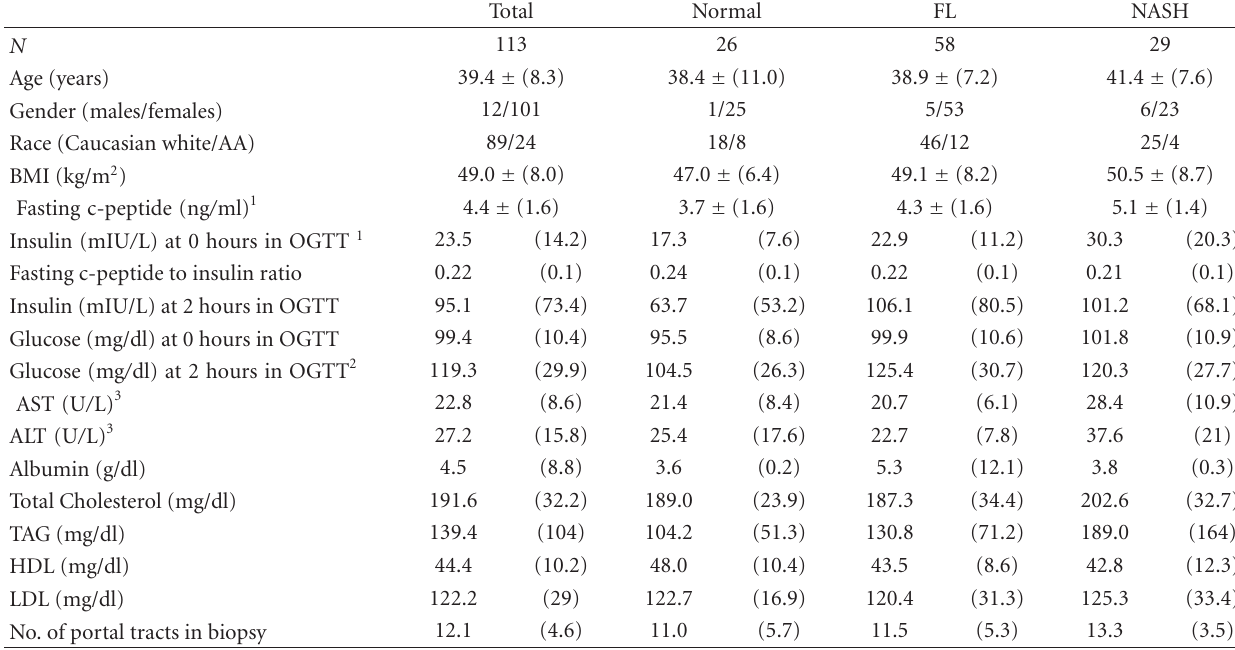
Table 1: Population Description . Breakup of study population according to the NAFLD spectrum is shown. Data represents Mean ± ( SD ).